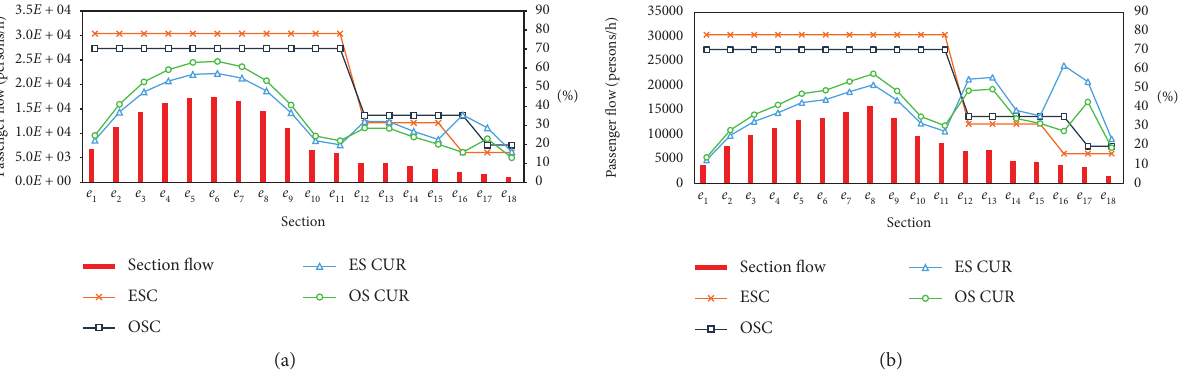
Figure 10: Section flow and capacity utilization ratio. (a) Inbound direction. (b) Outbound